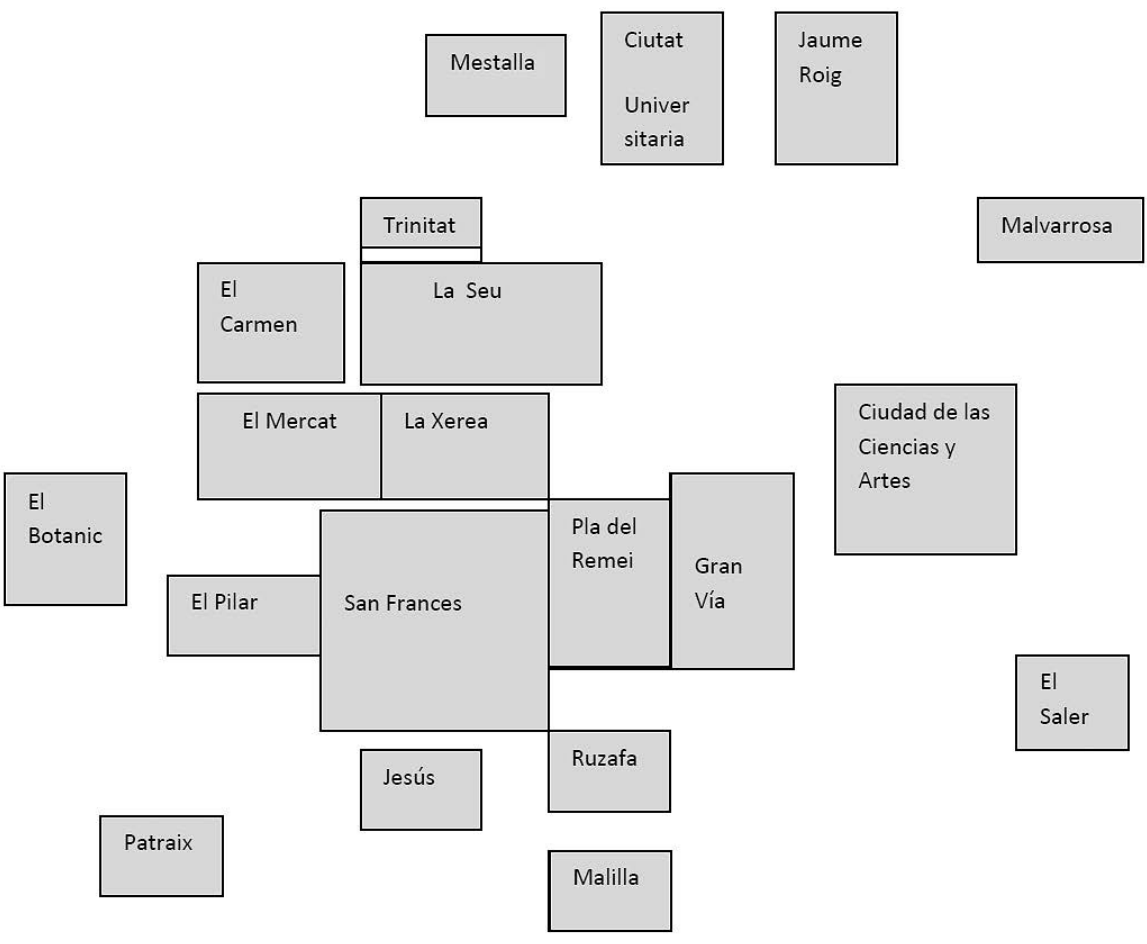
Fig. 8. Valencia’s neighbourhoods.